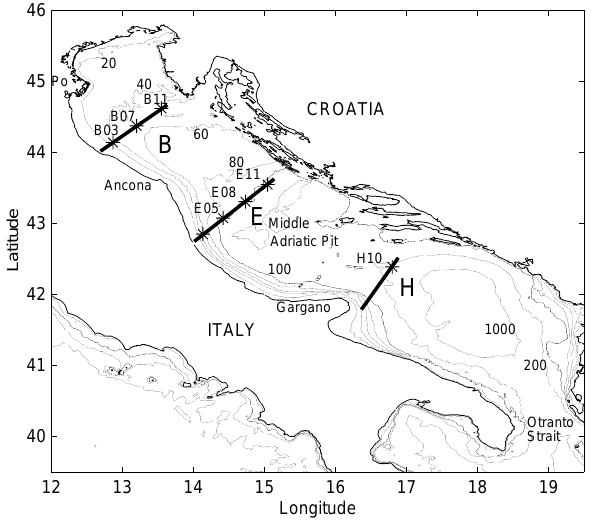
Fig. 1. The Adriatic Sea and its bathymetry. The three main sections analysed in the text are depicted together with moored current-meter positions.